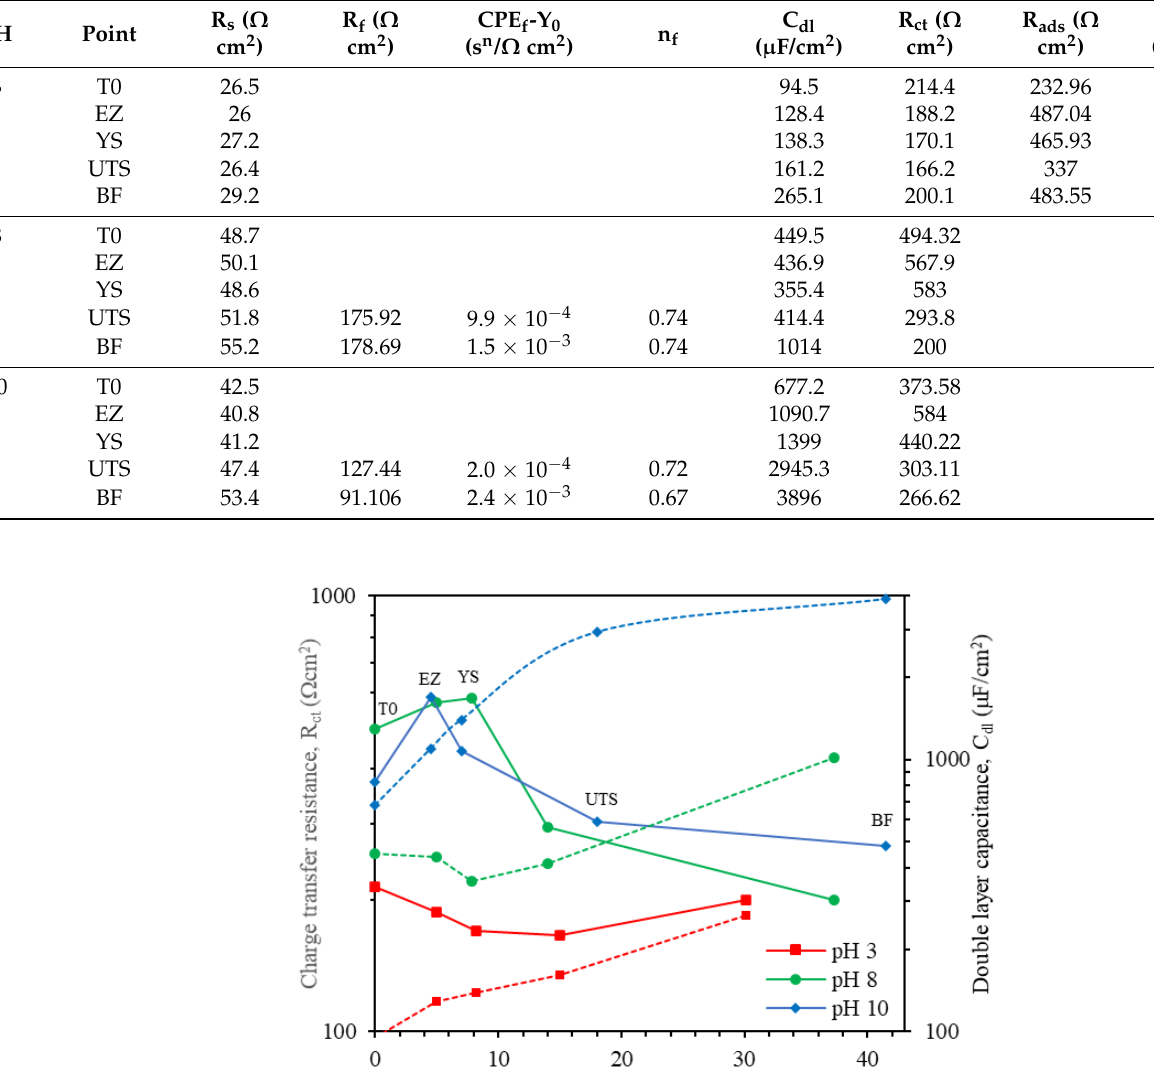
Table 3. EIS parameters obtained by fitting data to the EEC from Figure 6.